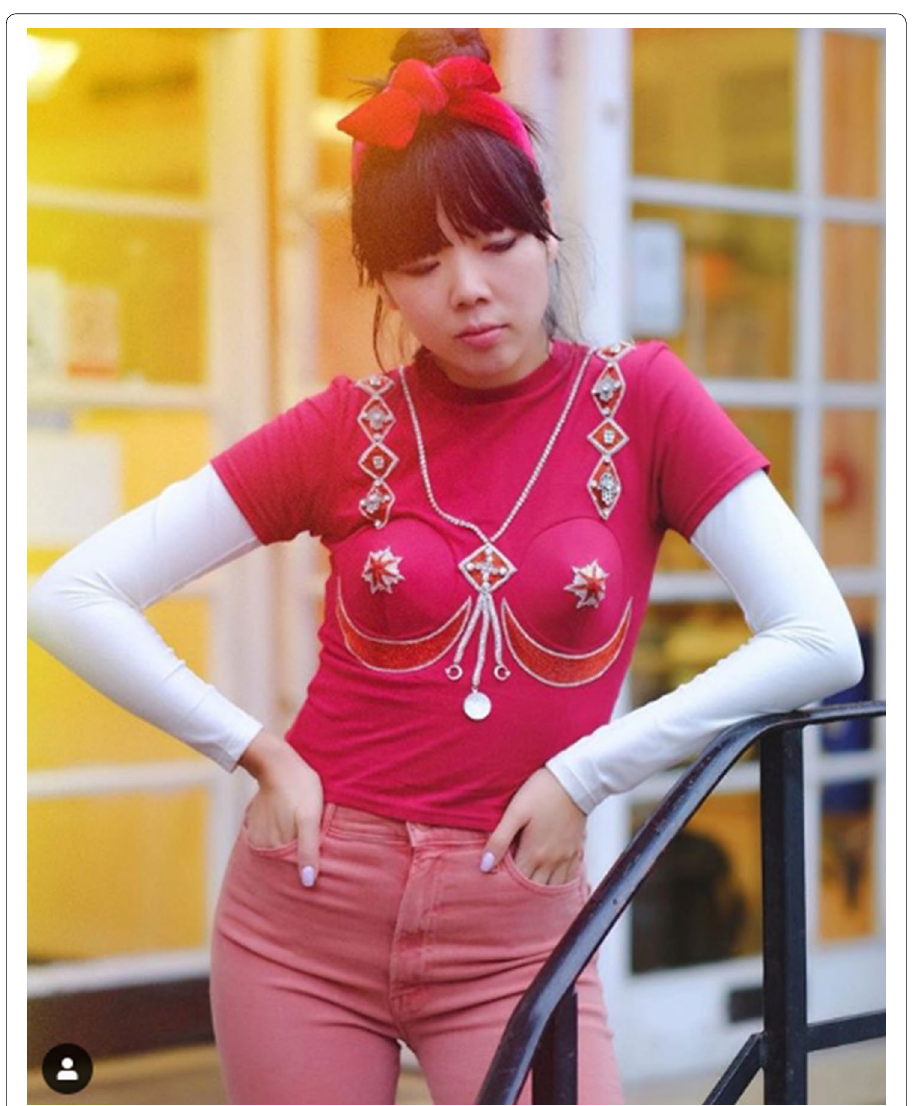
Fig. 18 Vive la Dilara Revolution. https ://www.insta gram.com/p/Bqw6q 0uhEc 4/. Accessed 4 October